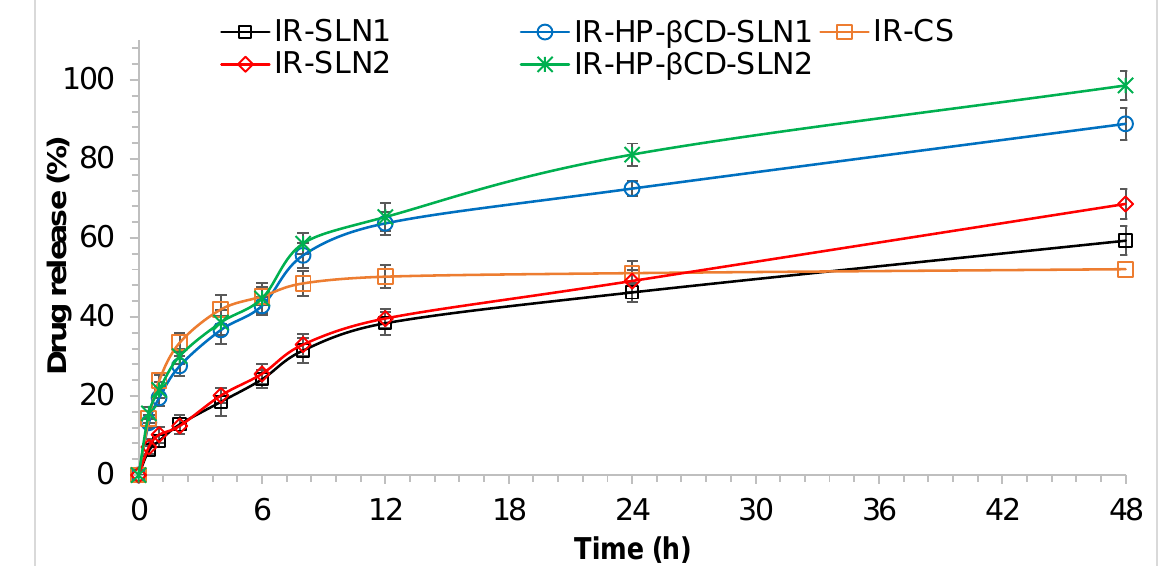
Figure 3. The in vitro release profile of irbesartan from IR-CS, IR-SLN, and IR-CD-SLN (mean ± SD, n = 4).